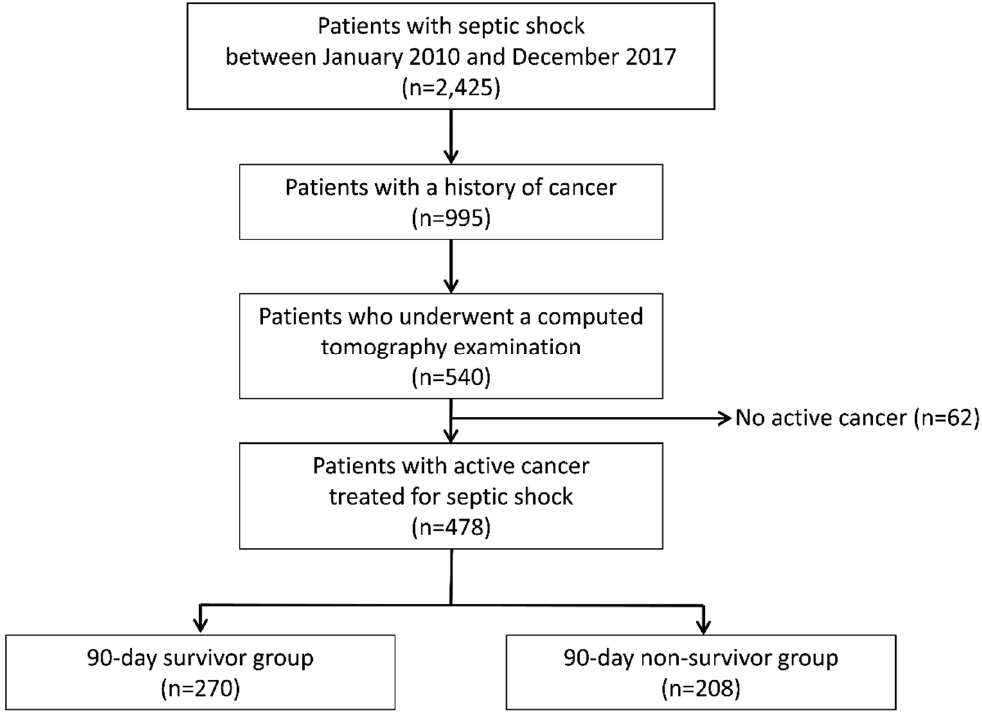
Figure 1. Flow diagram of patient enrolment and allocation in our study.